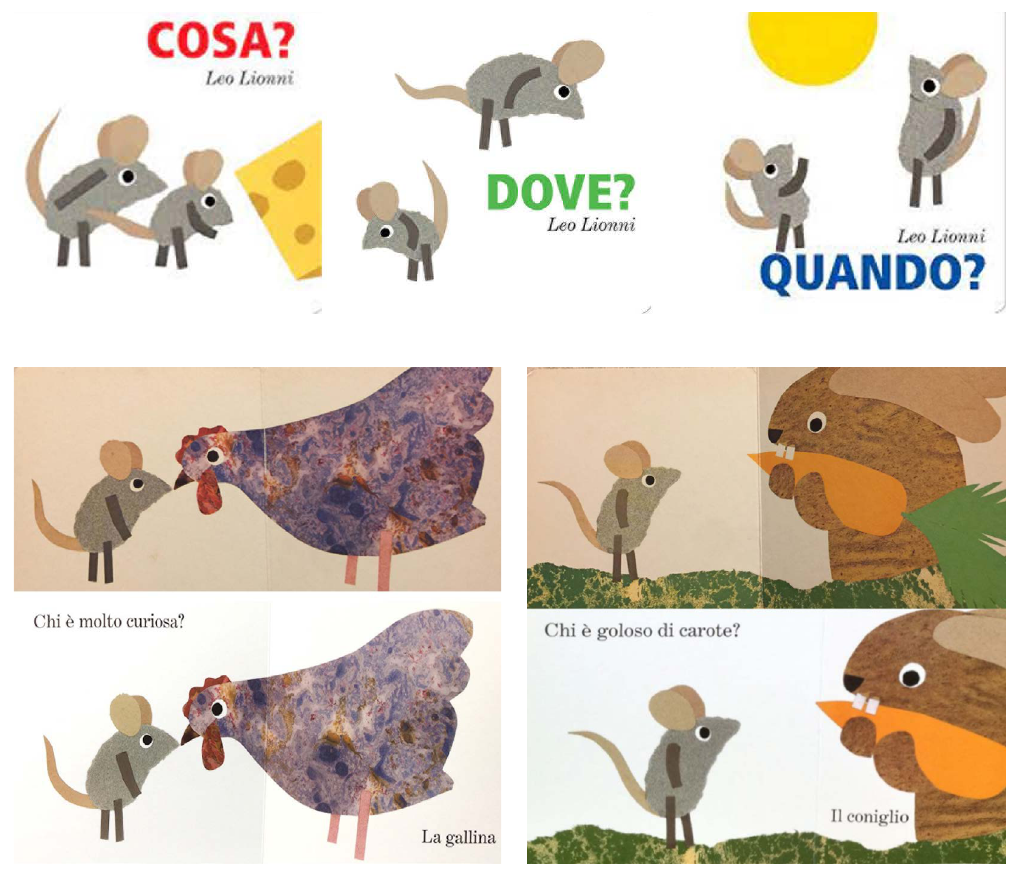
Fig. 22 Leo Lionni. Due topolini curiosi . 2017. Fig. 23 Comparison of the same pages of the two editions, 1991 and